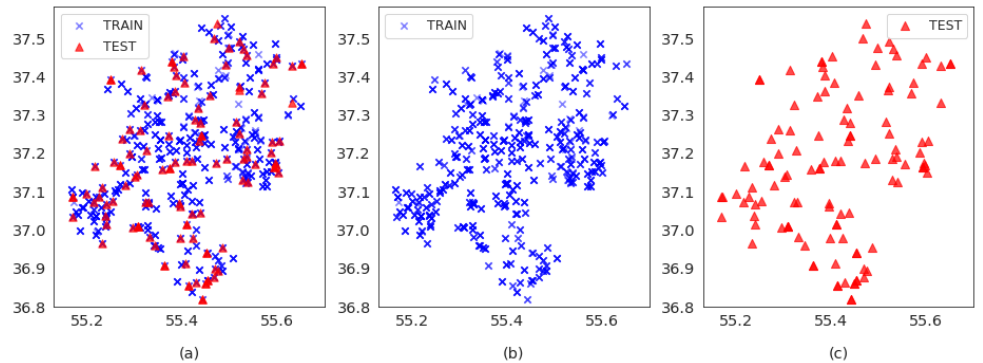
Figure 4. ( a ) Training and test sample sets. ( b ) Training part is 90% of the whole sample set, ( c ) test part—10%. Samples evenly cover the whole area of